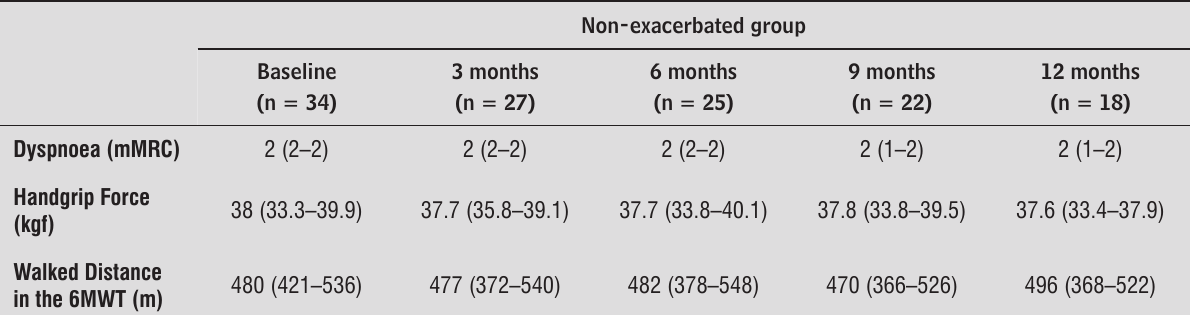
Table 2 - Body Composition, dyspnoea, handgrip force of both groups over the 12-month follow up Non-exacerbated group